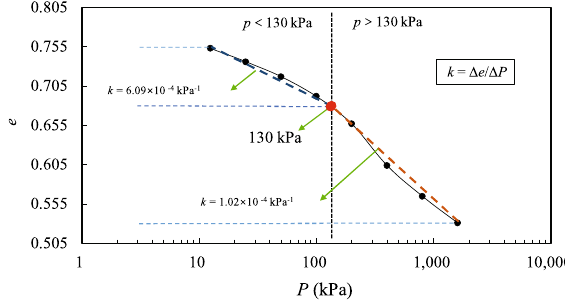
Figure 4. e –lg P curve.